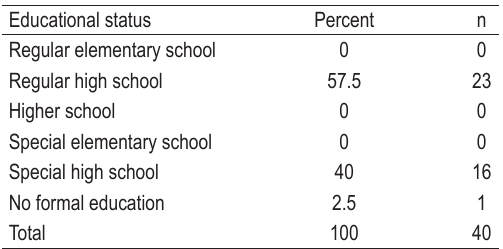
TABLE 3. Educational status of 40 individuals with hearing